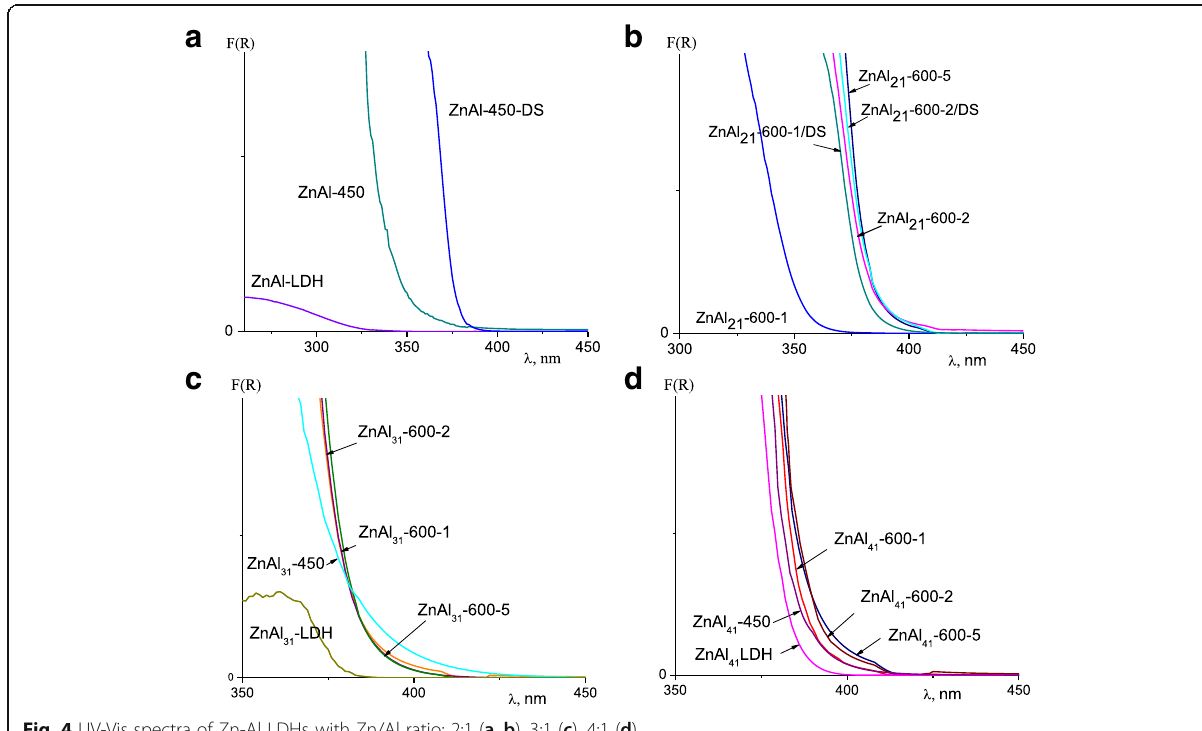
Fig. 4 UV-Vis spectra of Zn-Al LDHs with Zn/Al ratio: 2:1 ( a , b ), 3:1 ( c ), 4:1 ( d caused by ZnO phase, the LDHs with Zn/Al ratio 4:1 demonstrated the best results in MB photodestruction. The changes in the absorbance spectra of MB solution over different time of irradiation in the presence of Table 2 The photocatalytical MB removal with as-synthesized and calcined Zn-Al LDHs Sample Bandgap, Adsorption Photodestruction Total eV removal, % % mg/g %